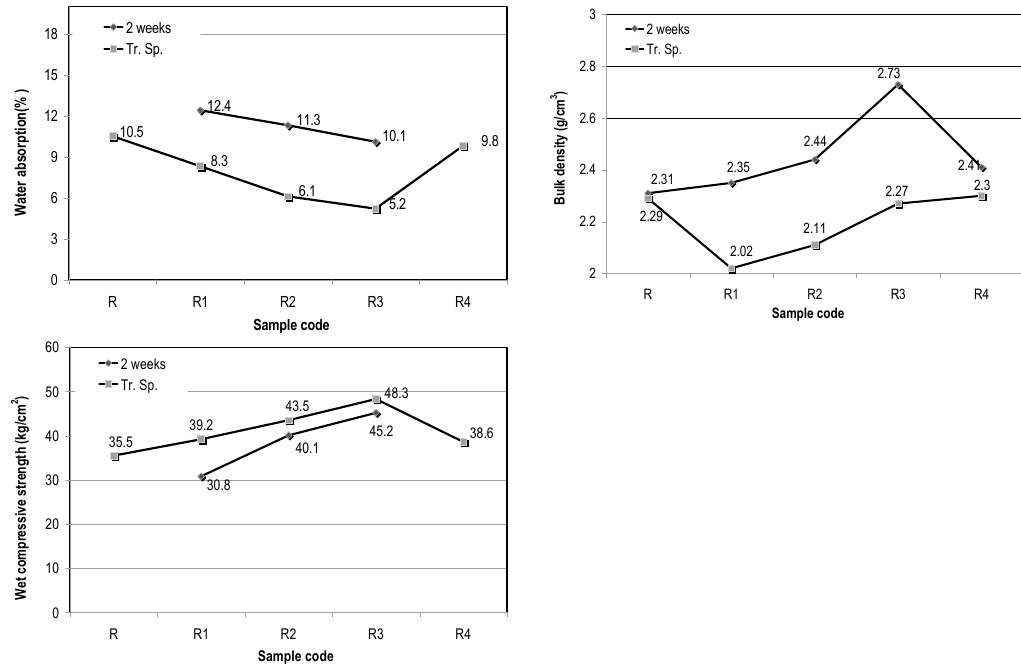
Figure 7. Comparison properties between the treated specimens (Tr. Sp.) and specimens cured for two weeks.